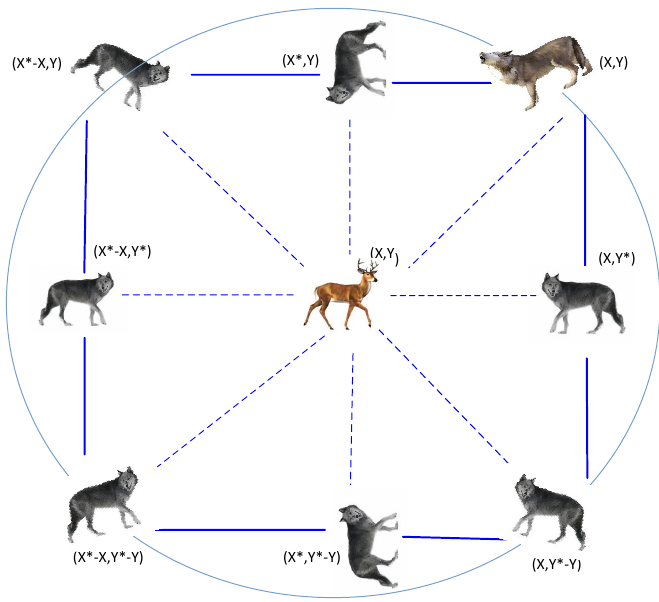
Figure 1. Grey wolf social hierarchy.